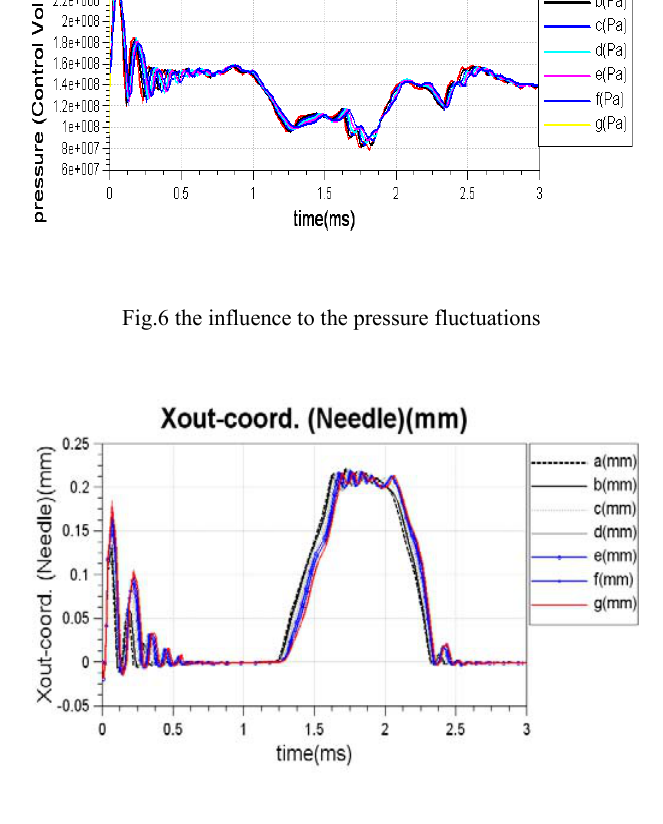
Fig.7 the influence to the needle